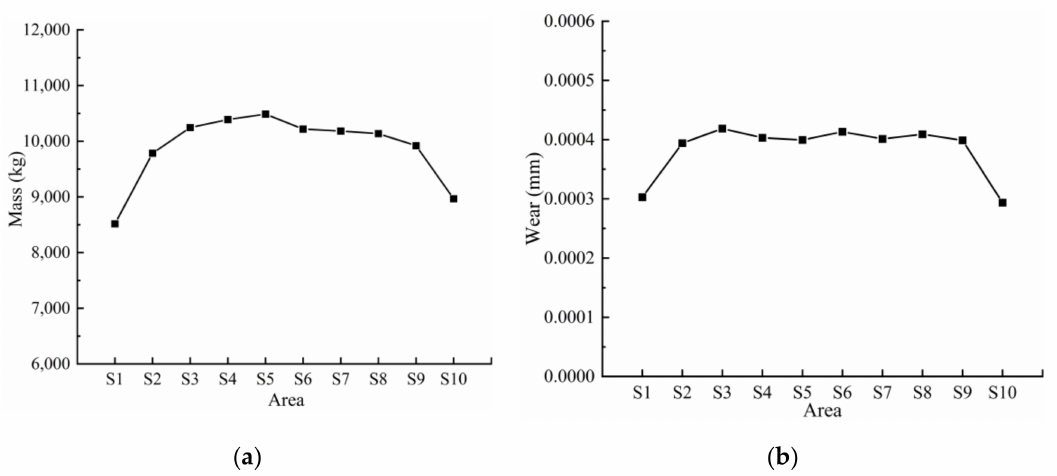
Figure 6. ( a ) The total mass of particles in each area in the simulation at 40 s. ( b ) The average cumulative wear of each area in the simulation at 40